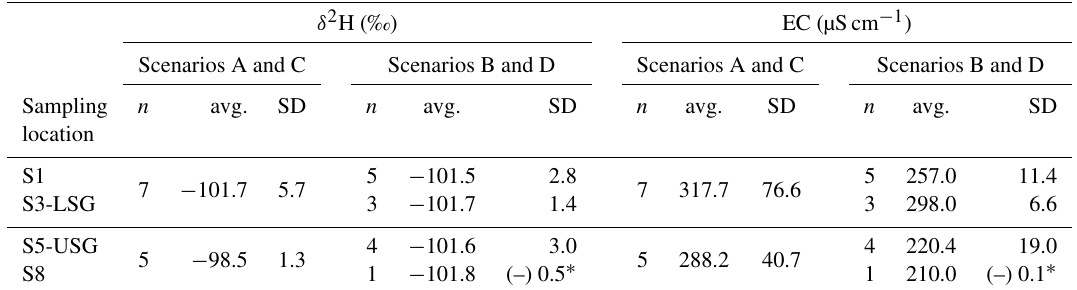
Table 3. Isotopic composition ( δ 2 H) and EC of the groundwater end-member used in the two- and three-component mixing model for the four scenarios for 2013 data. n : number of samples; avg.: average; SD: standard